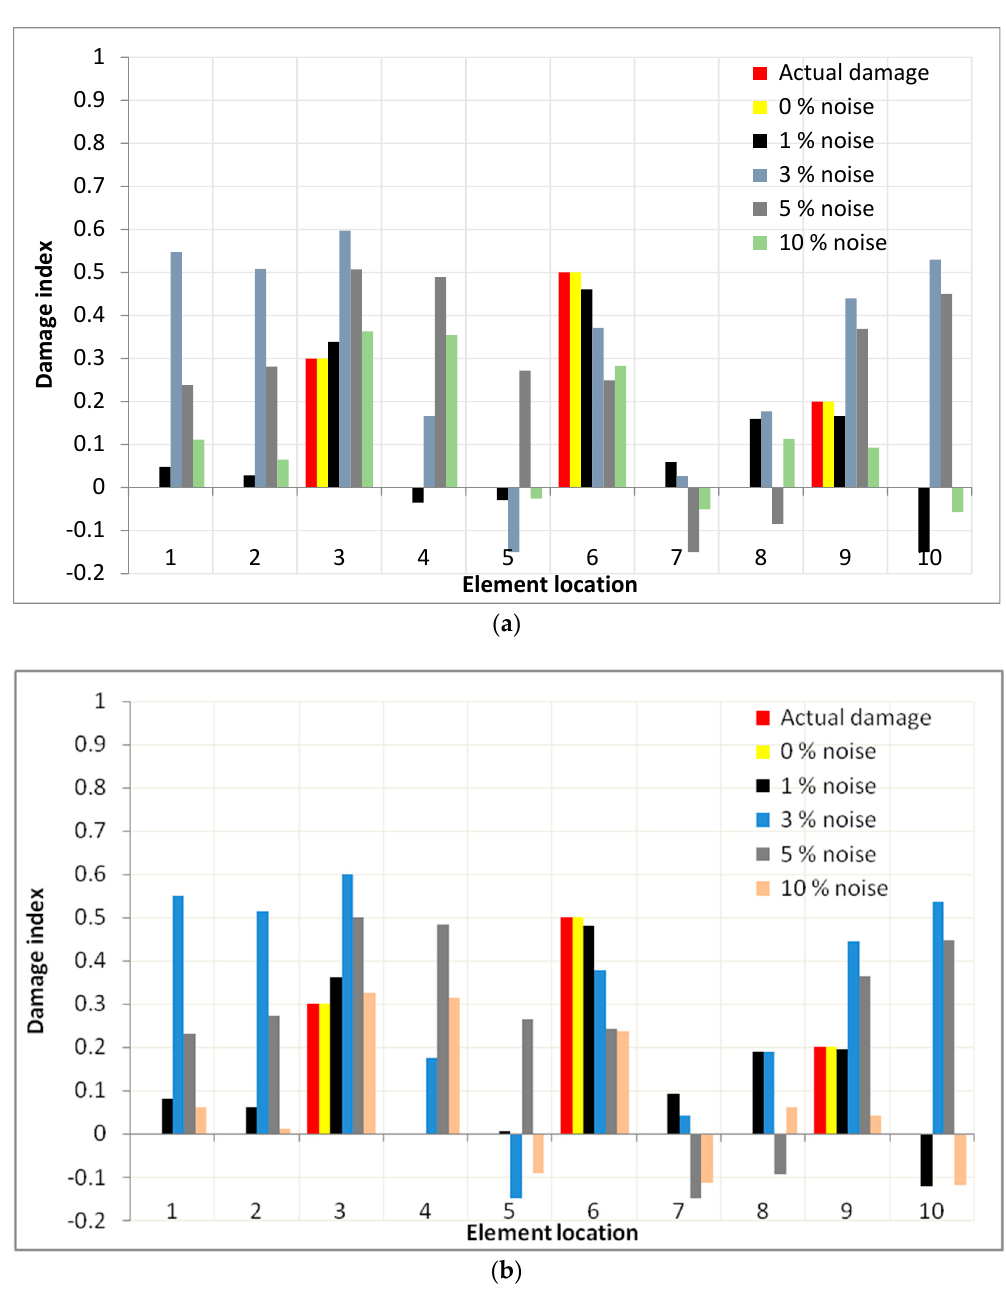
Figure 10. Damage distribution for Case 2 using Objective Function II for ( a ) noise both in frequency and mode shapes and ( b ) noise in mode shapes only.